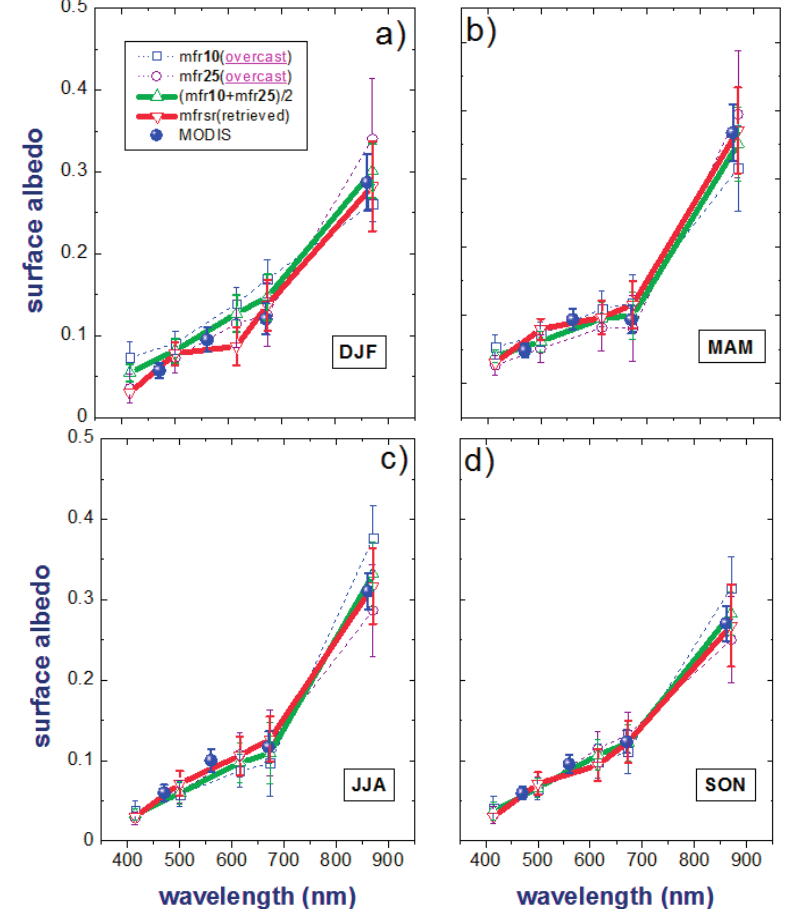
Figure 7. Spectral surface albedo values for overcast conditions during five-year period (2008–2013). Mean values (±standard deviations) of the tower-measured 10-m (blue-dotted) and 25-m (magenta-dotted) albedo, their weighted average (solid-green), MODIS-derived (blue) and areal-averaged albedo (solid-red) as a function of wavelength for four seasons: winter ( a ); spring ( b ); summer ( c ) and fall ( d